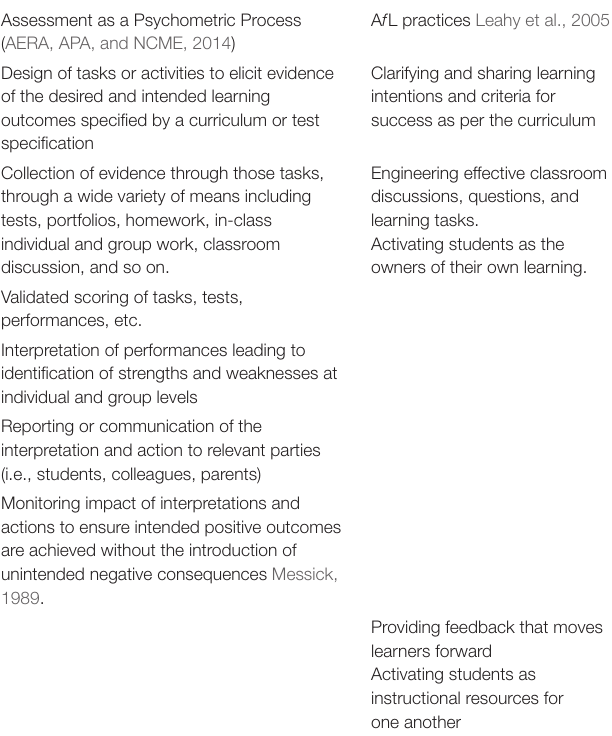
A f L practices Leahy et al., 2005 Clarifying and sharing learning intentions and criteria for success as per the